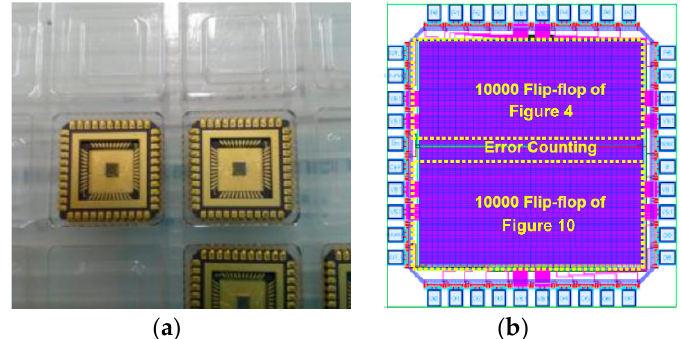
Figure 9. ( a ) Test chip photo, ( b ) layout floorplan.